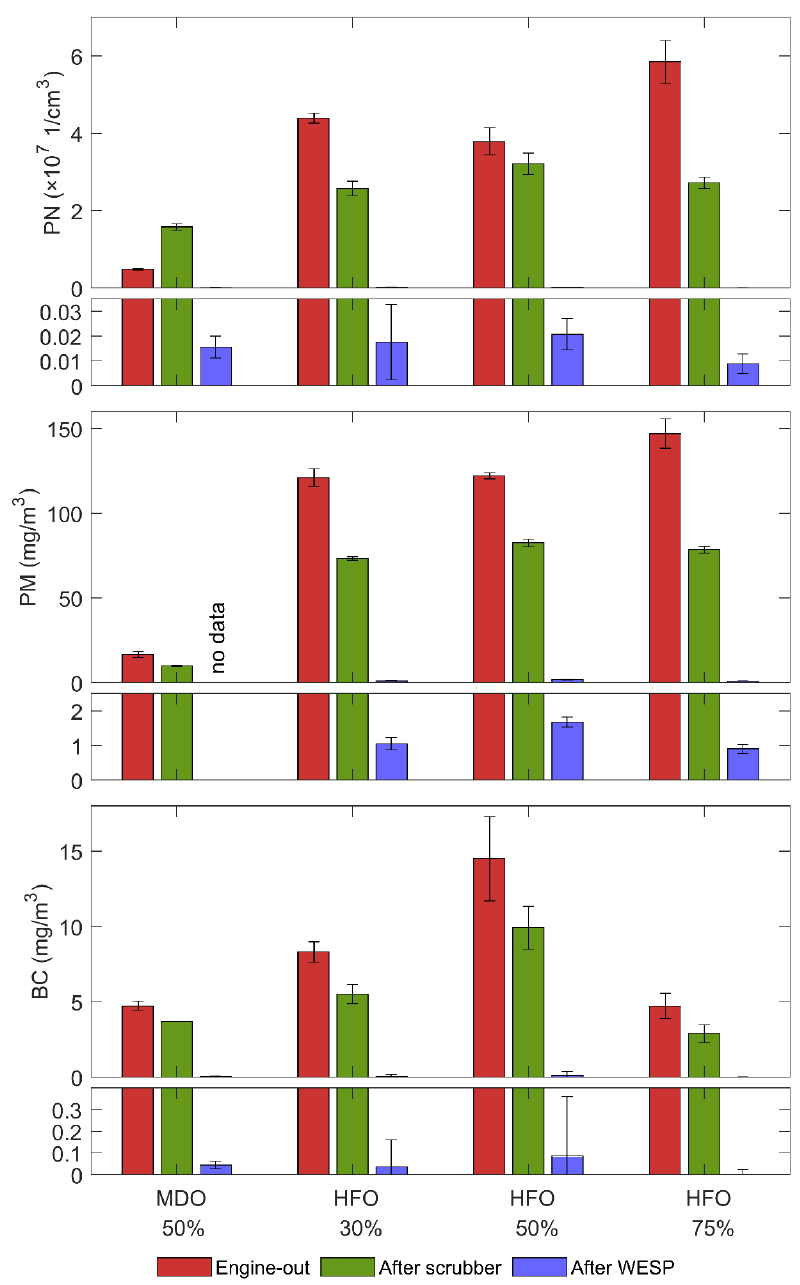
Figure 2. Measured particle number (PN), particulate matter (PM) and black carbon (BC) concen- trations from engine-out, after scrubber and after WESP positions. Fuel and engine load are shown in the x-axis. Error bars represent standard deviation of the measurement. Small figures present detailed view of after WESP concentrations.